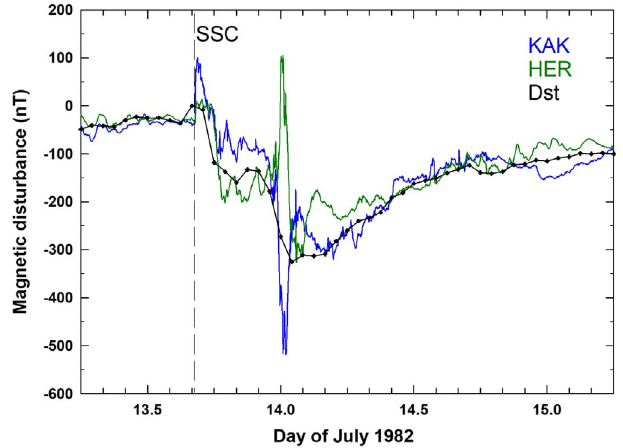
Fig. 2. H -component recorded at Kakioka (KAK, blue) and Hermanus (HER, green) geomagnetic observatories during the magnetic storm on 13 – 14 July of 1982. The Dst index (black) is also included for comparison with local records. The vertical dashed line corresponds to the time of the SSC of the storm.